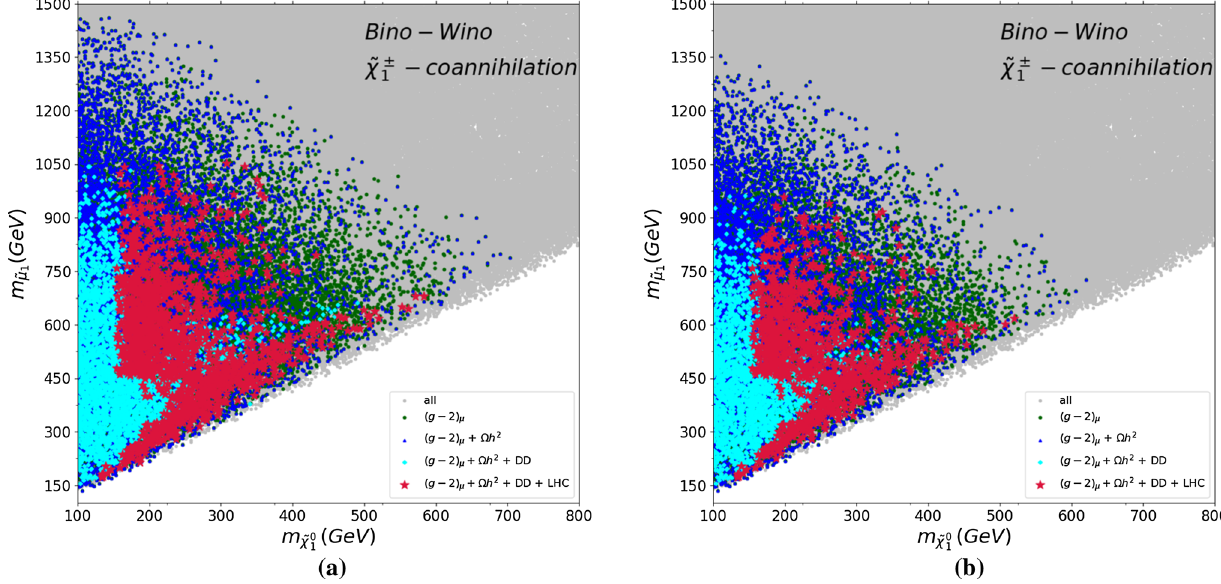
Fig. 13 The results of our parameter scan in the m ˜ χ 0 future limits (right) from ( g − 2 ) μ . The color coding is as in Fig.